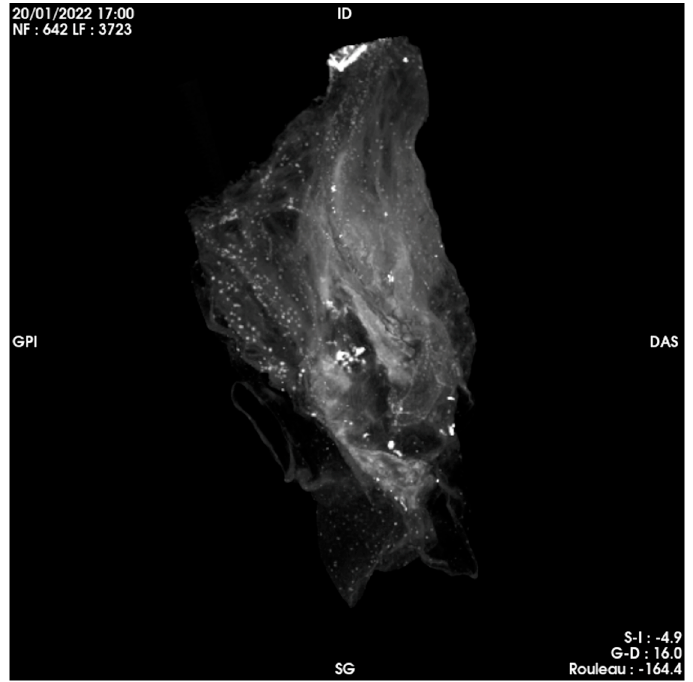
Figure 6. Three-dimensional reconstruction of the heart of Pauline